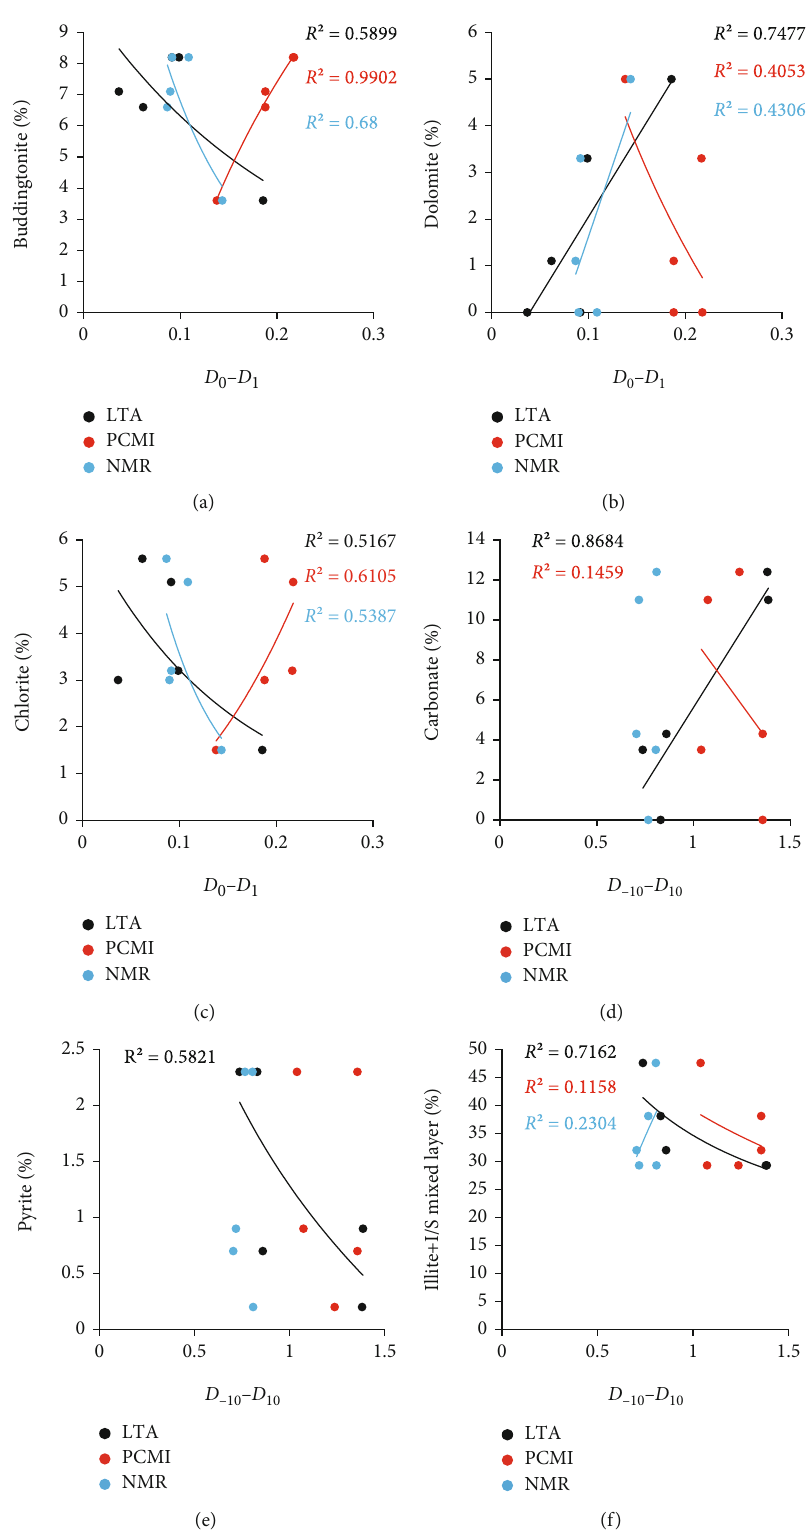
Figure 12: The impact on multifractal parameter from mineralogy: D - D vs. (d) carbonate; (e) pyrite; (f) clay (illite+I/S mixed layer in this and D − 10 10